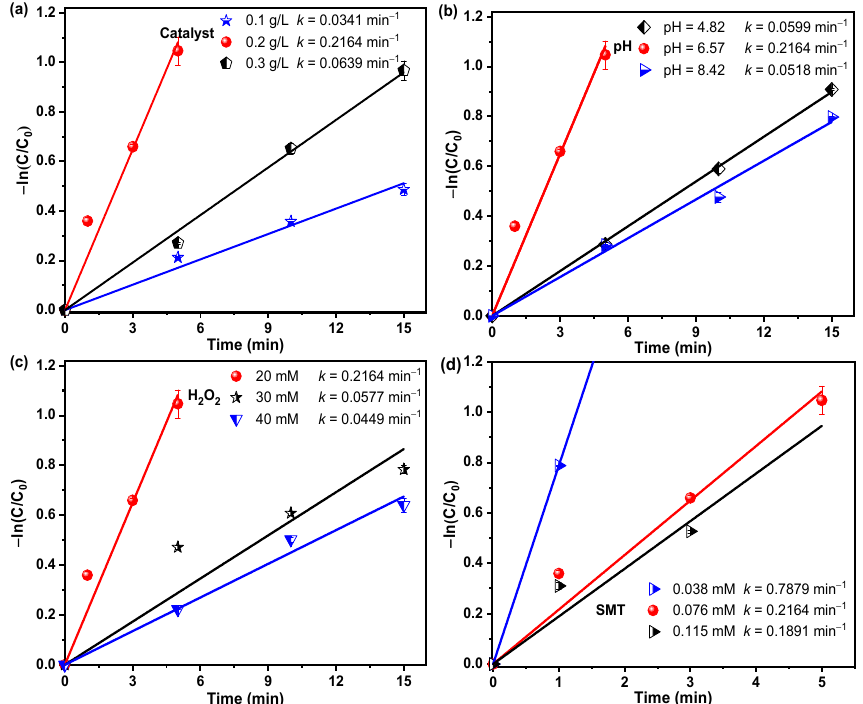
Figure 6. The kinetics curves for the SMT removal over the Fe-Mo/rGO catalyst under different operating conditions. (( a ) Catalyst dosage: [SMT] 0 = 0.076 mM, [H 2 O 2 ] 0 = 20 mM, pH = 6.57, T = 25 °C; ( b ) pH value: [SMT] 0 = 0.076 mM, [Catalyst] = 0.2 g/L, [H 2 O 2 ] 0 = 20 mM, T = 25 °C; ( c ) H 2 O 2 concentration: [SMT] 0 = 0.076 mM, [Catalyst] = 0.2 g/L, pH = 6.57, T = 25 °C; ( d ) SMT concentration: [Catalyst] = 0.2 g/L, [H 2 O 2 ] 0 = 20 mM, pH = 6.57, T = 25 °C).